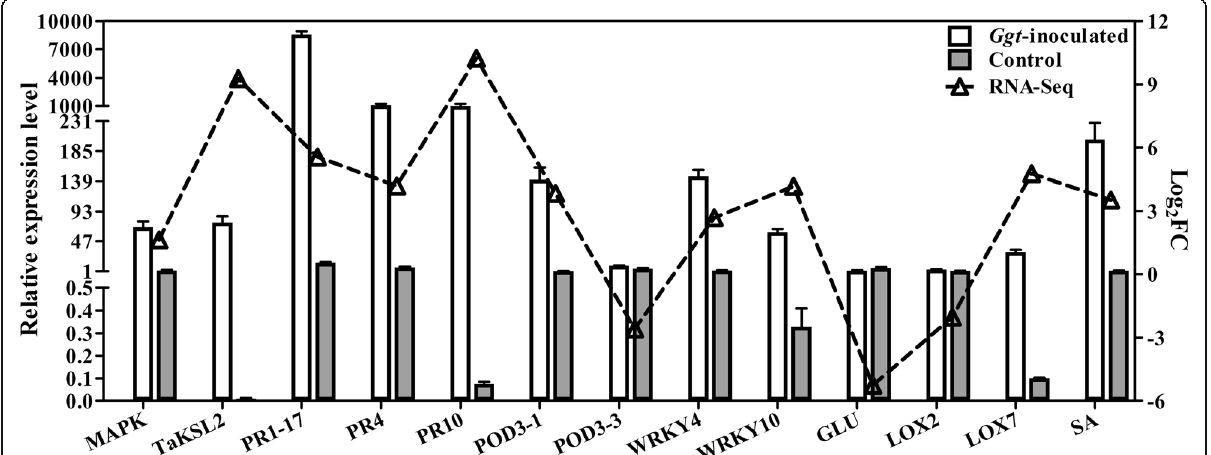
Fig. 6 Comparison of measurements of gene expression of selected DEGs by RT-qPCR and RNA-seq. Bars with standard errors represent the relative expression level of DEGs determined by RT-qPCR using the 2 - ΔΔ CT method from three biological replicates in three independent experiments (left Y-axis). Columns in white represent Ggt -inoculated samples, and columns in gray represent control samples. Broken lines indicate transcript abundance changes (log 2 fold change) based on FPKM values from RNA-Seq analysis (right